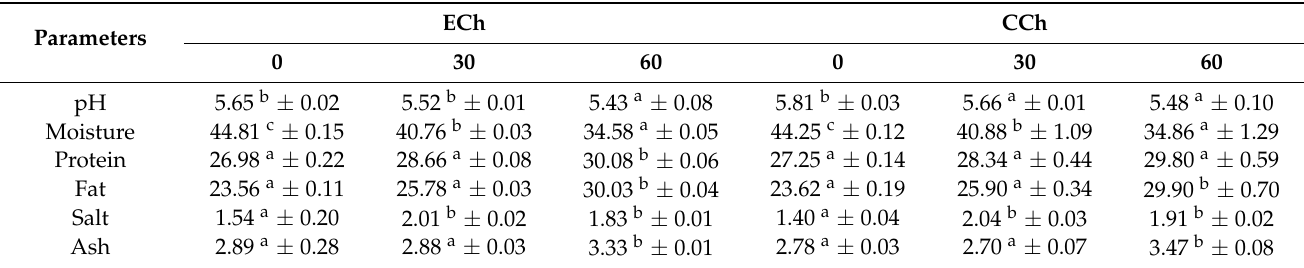
Table 5. Physico-chemical characteristics of experimental (ECh) and control (CCh) cheeses at 0, 30 and 60 days of ripening.